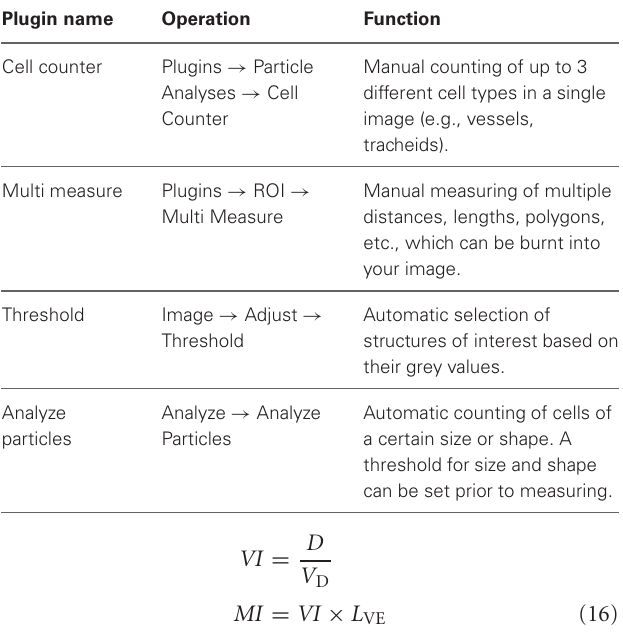
Table 3 | Overview of useful plugins for image analysis using